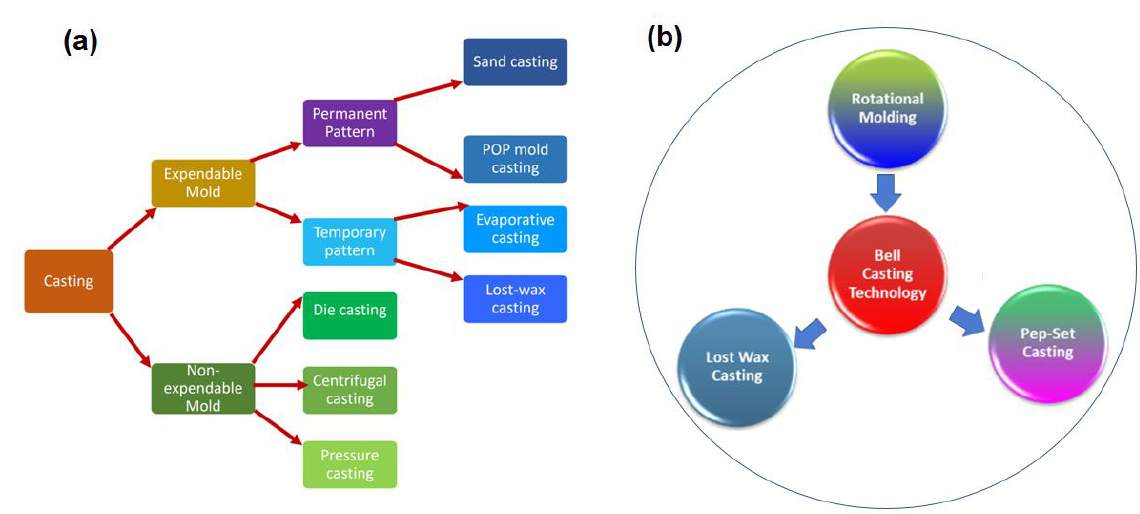
Figure 6. ( a ) Metal casting technologies and ( b ) popular bronze cast technologies for